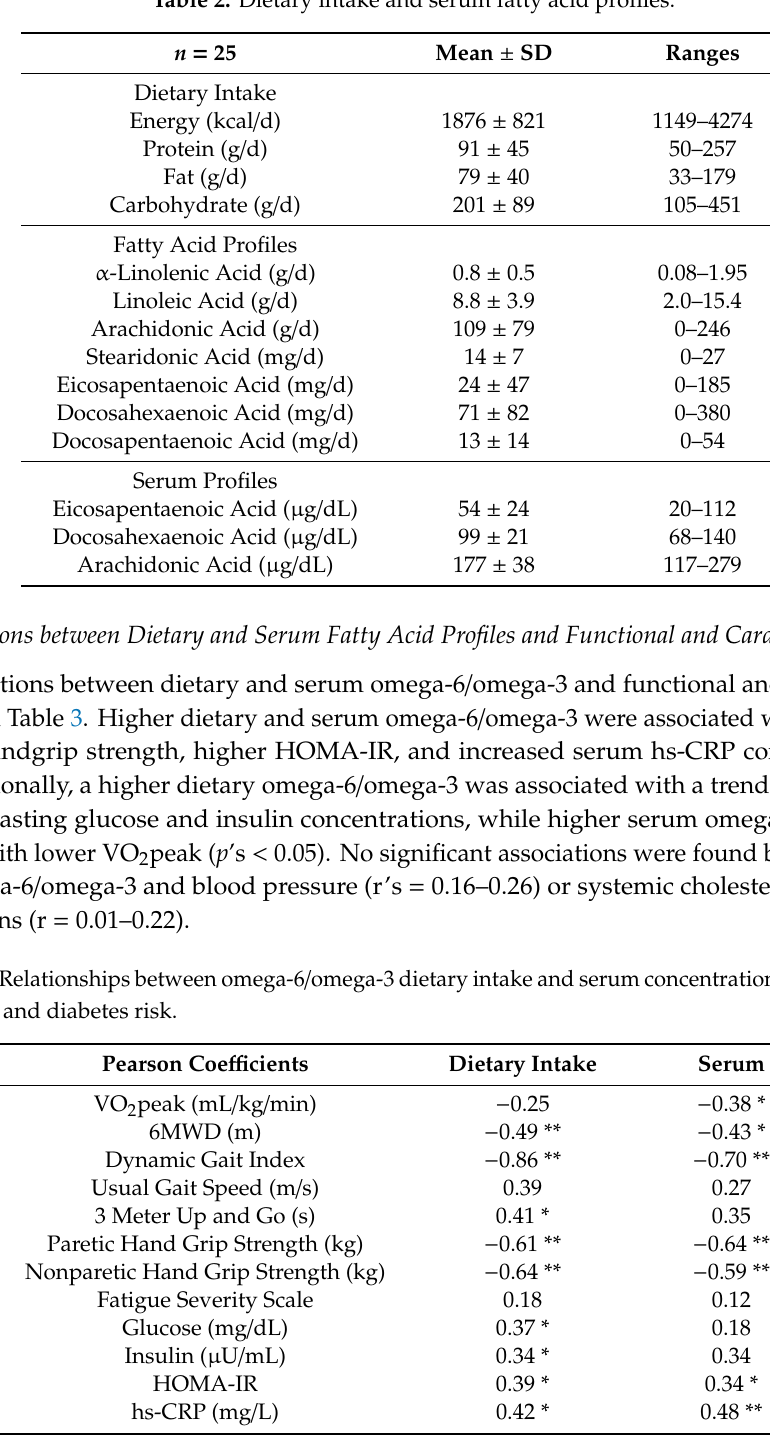
Table 2. Dietary intake and serum fatty acid profiles.